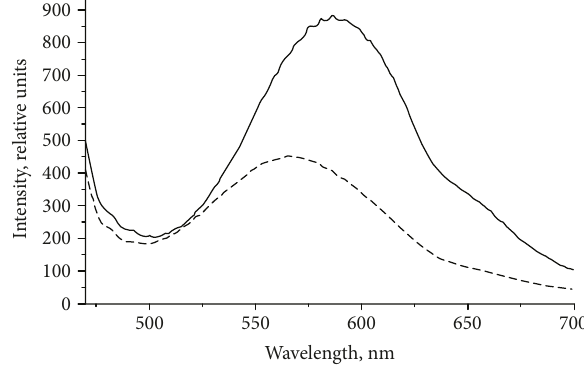
Figure 2: Fluorescence spectra of OMS in the CAGF fi lm before (dashed line) and after (solid line) incubation in the 10 -3 M ) solution. Ba(ClO 4 2